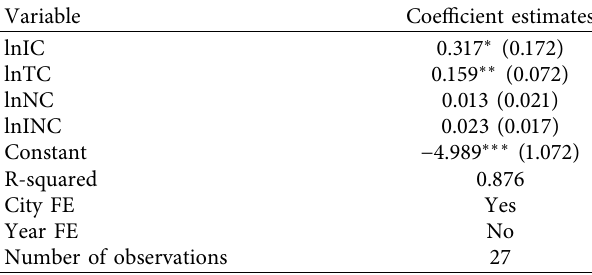
Table 5: Regression results of HDI and four